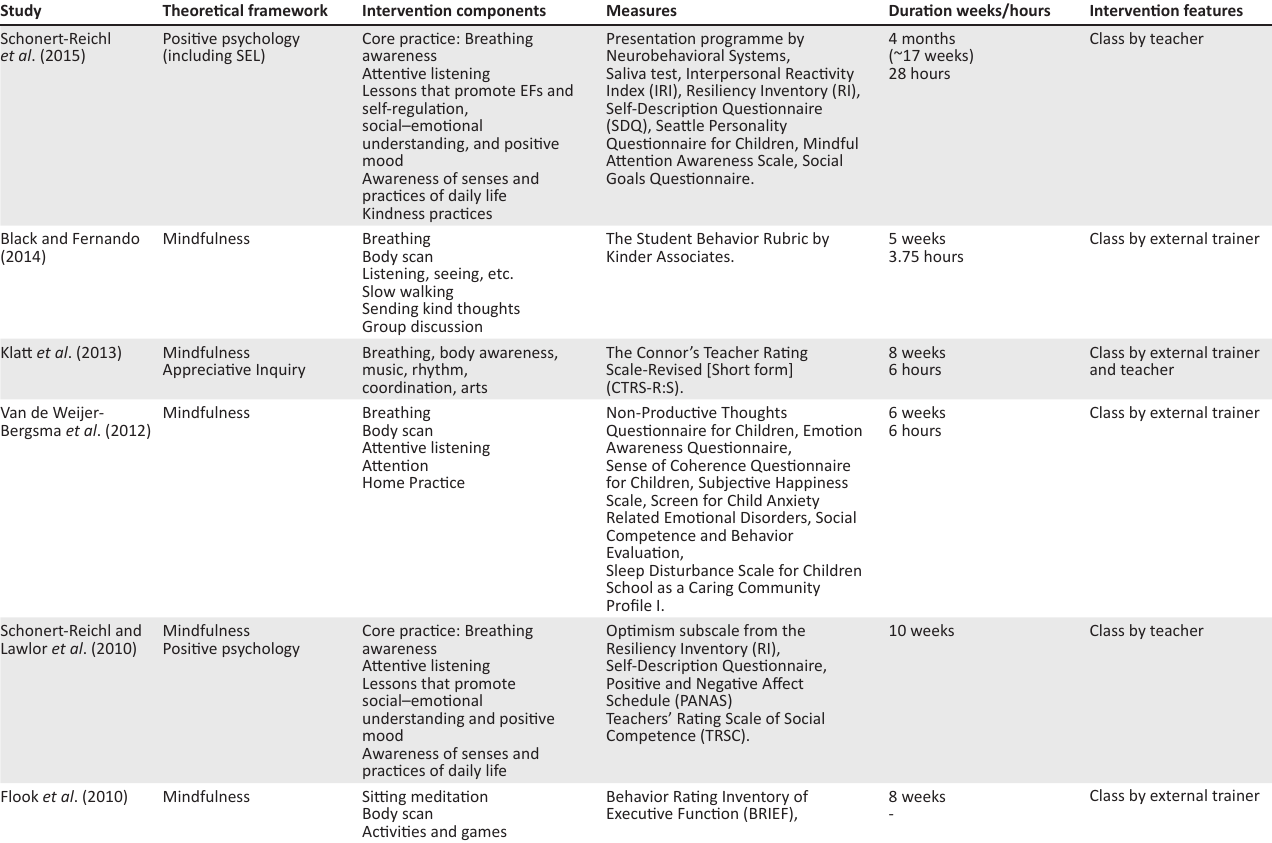
TABLE 2: General features of the